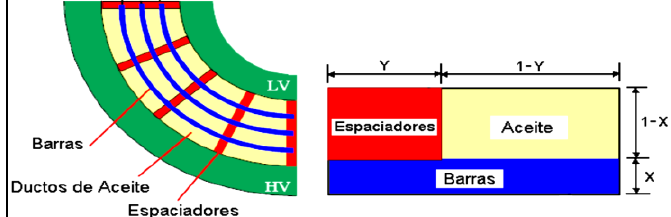
Figura 13: Modelo del sistema de aislamiento del transformador. Fuente: Autores,